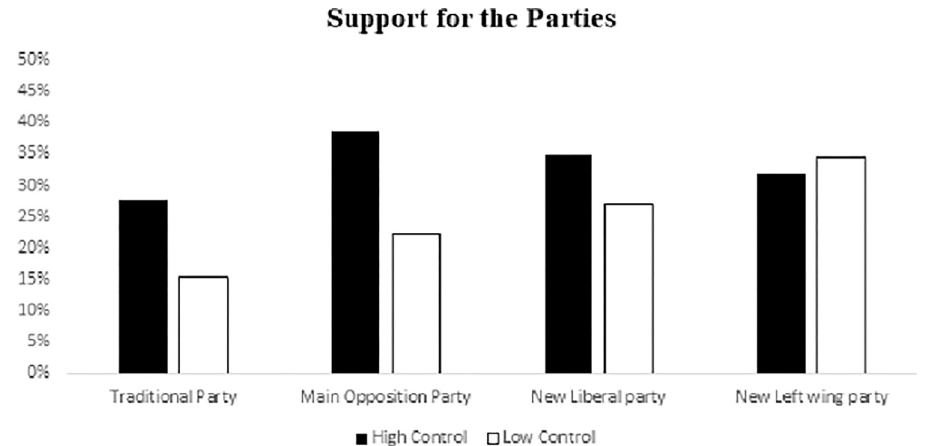
Fig 2. Support for the different political parties by experimental control condition (Traditional party